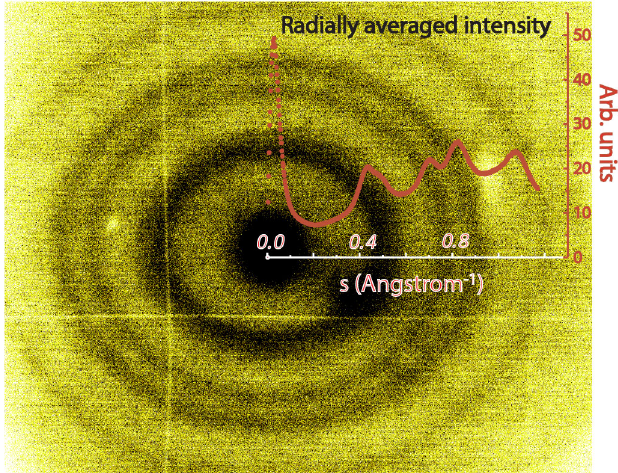
FIG. 1. (Color) Single-shot diffraction pattern taken with rela- tivistic ultrafast electron diffraction. The radially averaged in- tensity profile is also shown.